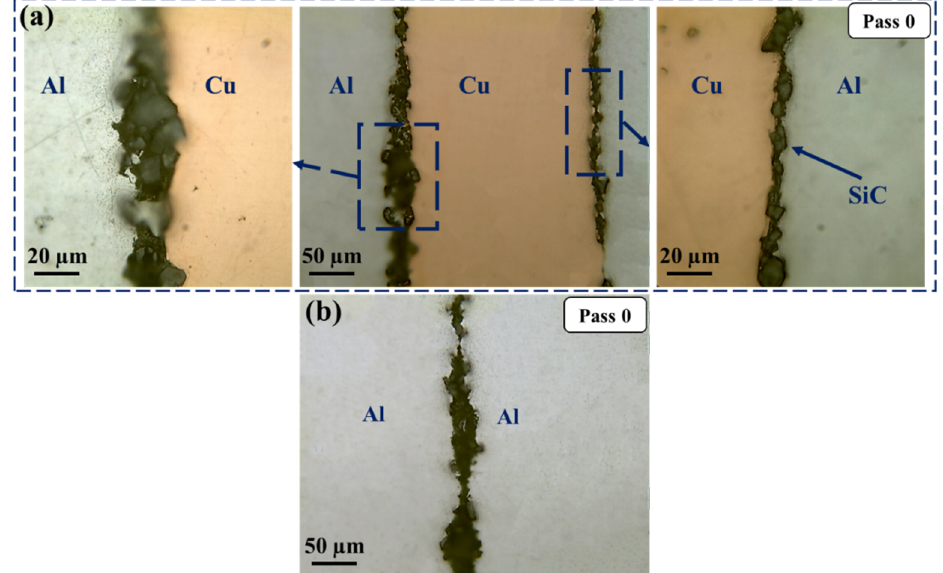
Figure 6. The cluster of SiC particles: ( a ) in Al/Cu and ( b ) at Al/Al interfaces.